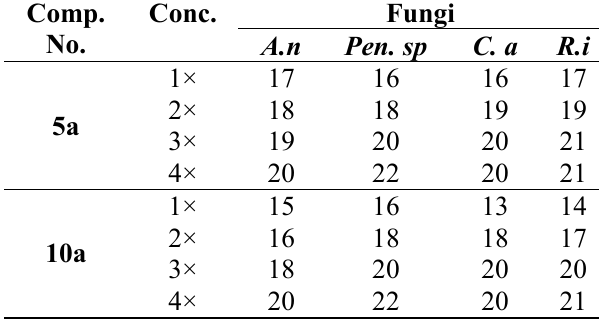
Table 5. Antifungal activity of compounds 5a and 10a at different concentrations.